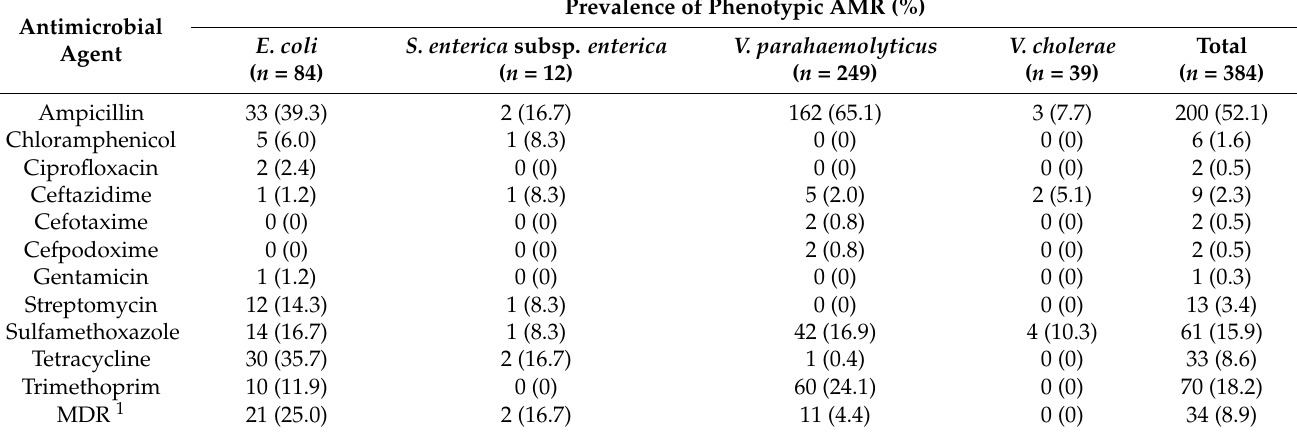
Table 1. Phenotypic characterization of AMR in E. coli , Salmonella , V. parahaemolyticus , and V. cholerae isolated from seawater from coastal Thailand.